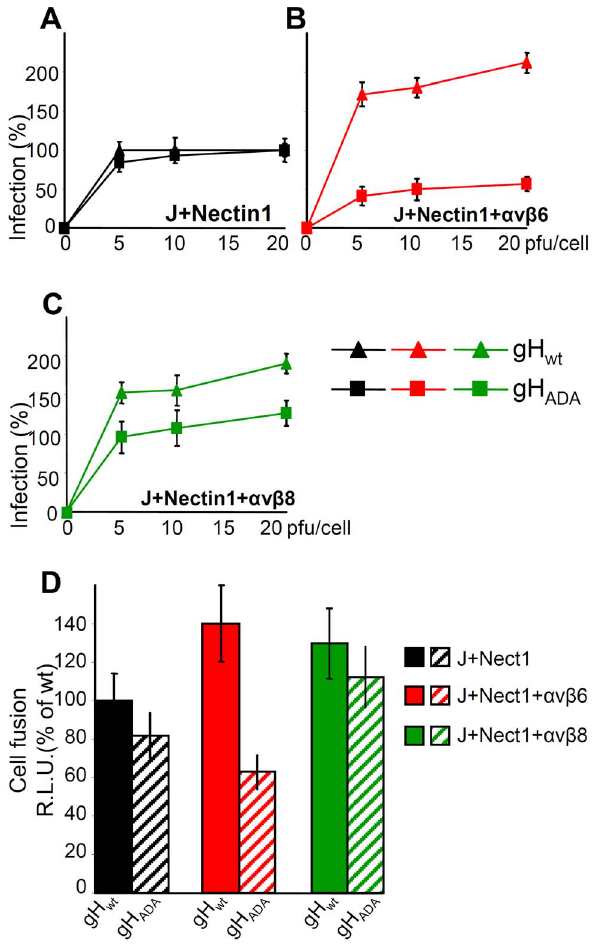
Figure 8. The RGD motif in gH is required for HSV infection and cell-cell fusion mediated by a v b 6–integrin, but not by a v b 8– integrin. (A–C). J cells were transfected with low amount of nectin1 alone (black triangle and square) (A), or nectin1 plus a v b 6-integrin (red triangle and square) (B), or nectin1 plus a v b 8-integrin (green triangle and square) (C), as detailed in legend to Fig. 7. 48 h later, cells were infected with increasing amounts (5–20 pfu/cell) of SCgHZ virus, a D gH HSV, complemented with gH wt (black, red and green triangle) or with gH ADA (black, red and green square), and harvested 16–18 h later. Extent of infection was expressed as detailed in legend to Fig. 3. Eeach point represents the average of triplicates. 100% of infection is the value obtained in J cells transfected with nectin1 alone and infected with 20 pfu of SCgHZ virus complemented with gH wt . Bars show SD. (D) Cell-to-cell fusion between effector J cells expressing gH wt , or gH ADA plus the trio of gD, gL and gB, and luciferase, and target J cells expressing nectin1 alone, or nectin1 plus a v b 6-integrin, or nectin1 plus a v b 8-integrin plus Renilla luciferase. Fusion was quantified by means of a T7 promoter-driven reporter luciferase gene transfected in effector cells, and expressed as percentage relative luciferase units (R.L.U.). 100% is the value obtained in cells expressing nectin1 alone and gH wt plus the trio of gD, gL, gB. Each point represents the average of triplicates. Bars show